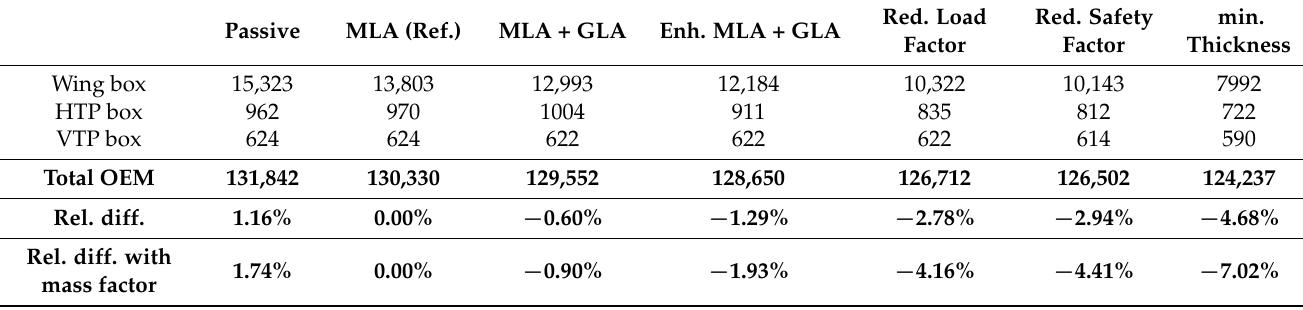
Table A3. Overview of the operating empty mass in